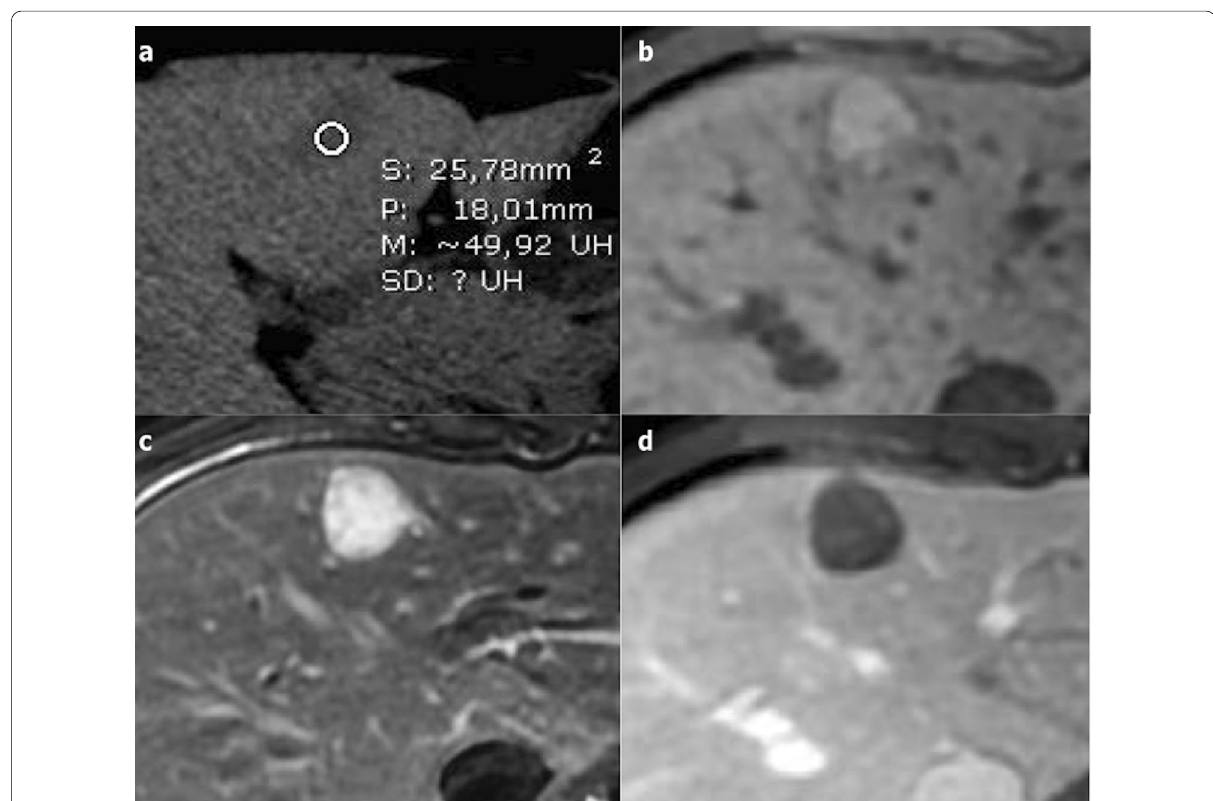
Fig. 18 Ciliated hepatic foregut duplication cyst in a 15-year-old male. a Axial non-enhanced computed tomography shows a subcapsular nodule of the fourth segment with spontaneous attenuation value of around 50 Hounsfield Units. b On axial T1-weighted magnetic resonance imaging, it is spontaneously hyperintense. c It displays a high level of hyperintensity on axial T2-weighted magnetic resonance imaging. d Axial T1-weighted magnetic resonance imaging on portal venous phase shows neither contrast enhancement nor wall